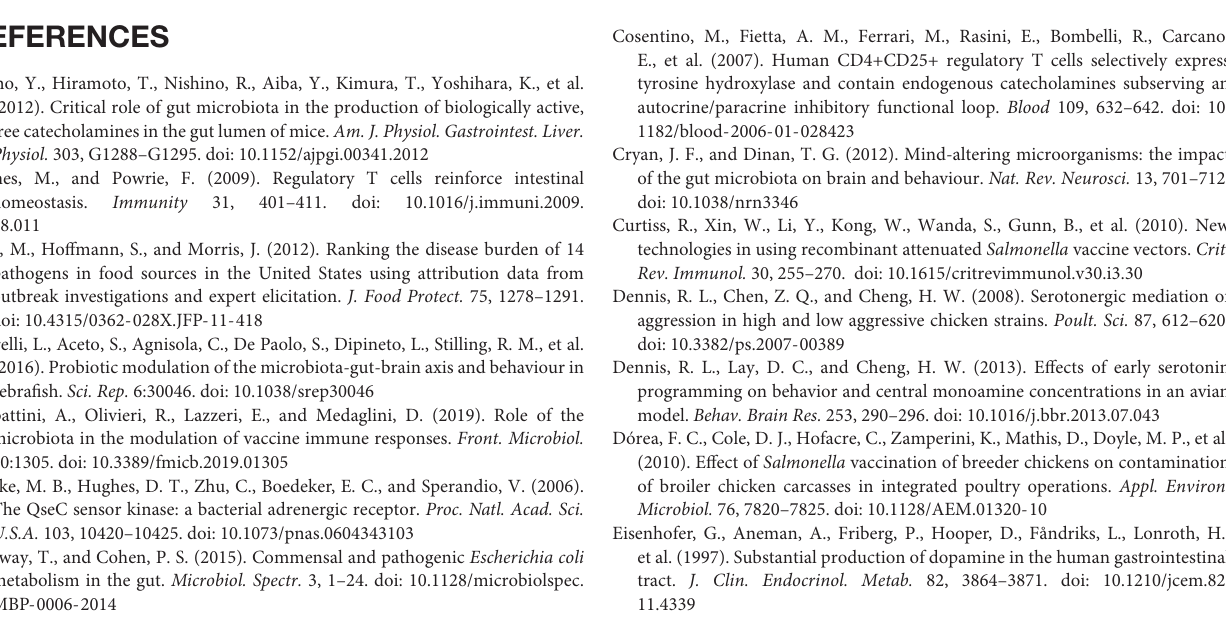
FIGURE S2 | Impact of treatment on microbial alpha diversity in the chicken ceca ( n = 10 per group) via (A) Faith’s PD (richness) and (B) evenness plots. Figures were generated via QIIME2 software. ∗ P < 0.05. Yellow, PRO; blue, VAX; green, P + V. FIGURE S3 | Bacterial abundances of specific classes influenced by treatment group. 16S reads for Clostridia and Gammaproteobacteria were generated by QIIME2 software, and figures were developed on GraphPad. Yellow, PRO; blue, VAX; green, P + V. ∗ P < 0.05; ∗∗ P < 0.01; ∗∗∗ P < 0.001. FIGURE S4 | Bacterial abundances by family influenced by treatment group. 16S reads for (A) Lachnospiraceae, (B) Peptostreptococcaceae, and (C) Mogibacteriaceae were generated by QIIME2 software, and figures were developed on GraphPad. Yellow, PRO; blue, VAX; green, P + V. ∗ P < 0.05; ∗∗ P < 0.01. FIGURE S5 | Bacterial genera influenced by treatment group. 16S reads for (A) Enterococcus , (B) Weisella , (C) Anaerofustis , (D) Clostridium , (E) Coprabacillus , and (F) Cc-115 were generated by QIIME2 software, and figures were developed on GraphPad. Yellow, PRO; blue, VAX; green, P + V. ∗ P < 0.05; ∗∗∗ P < 0.001. FIGURE S6 | Gneiss heatmap used to determine taxonomic shifts in microbial balances specific to Probiotics (PRO), Live Salmonella (VAX), and Probiotics and Live Salmonella (P + V). Figure was generated via QIIME2 analysis. FIGURE S7 | Plots for comparing normality of tyrosine: Akkermansia muciniphila linear regression models generated by R software. (A–D) No log transformation of A. muciniphila 16S reads. (E–H) Log-transformed A. muciniphila 16S reads. FIGURE S8 | Plots for comparing normality of norepinephrine:Enterobacteriaceae linear regression models generated by R software. (A–D) No log transformation of Enterobacteriaceae 16S reads. (E–H) Log-transformed Enterobacteriaceae 16S reads. TABLE S1 | This table includes (i) original 16S abundance data, (ii) HPLC data, and (iii) log-transformed 16S abundance data for each individual bird, used for correlation analyses. TABLE S2 | This table includes output from Gneiss plugin from QIIME2 analysis describing balance shifts via treatments. PRO, probiotics only; VAX, vaccine only; P + V, vaccine and probiotics